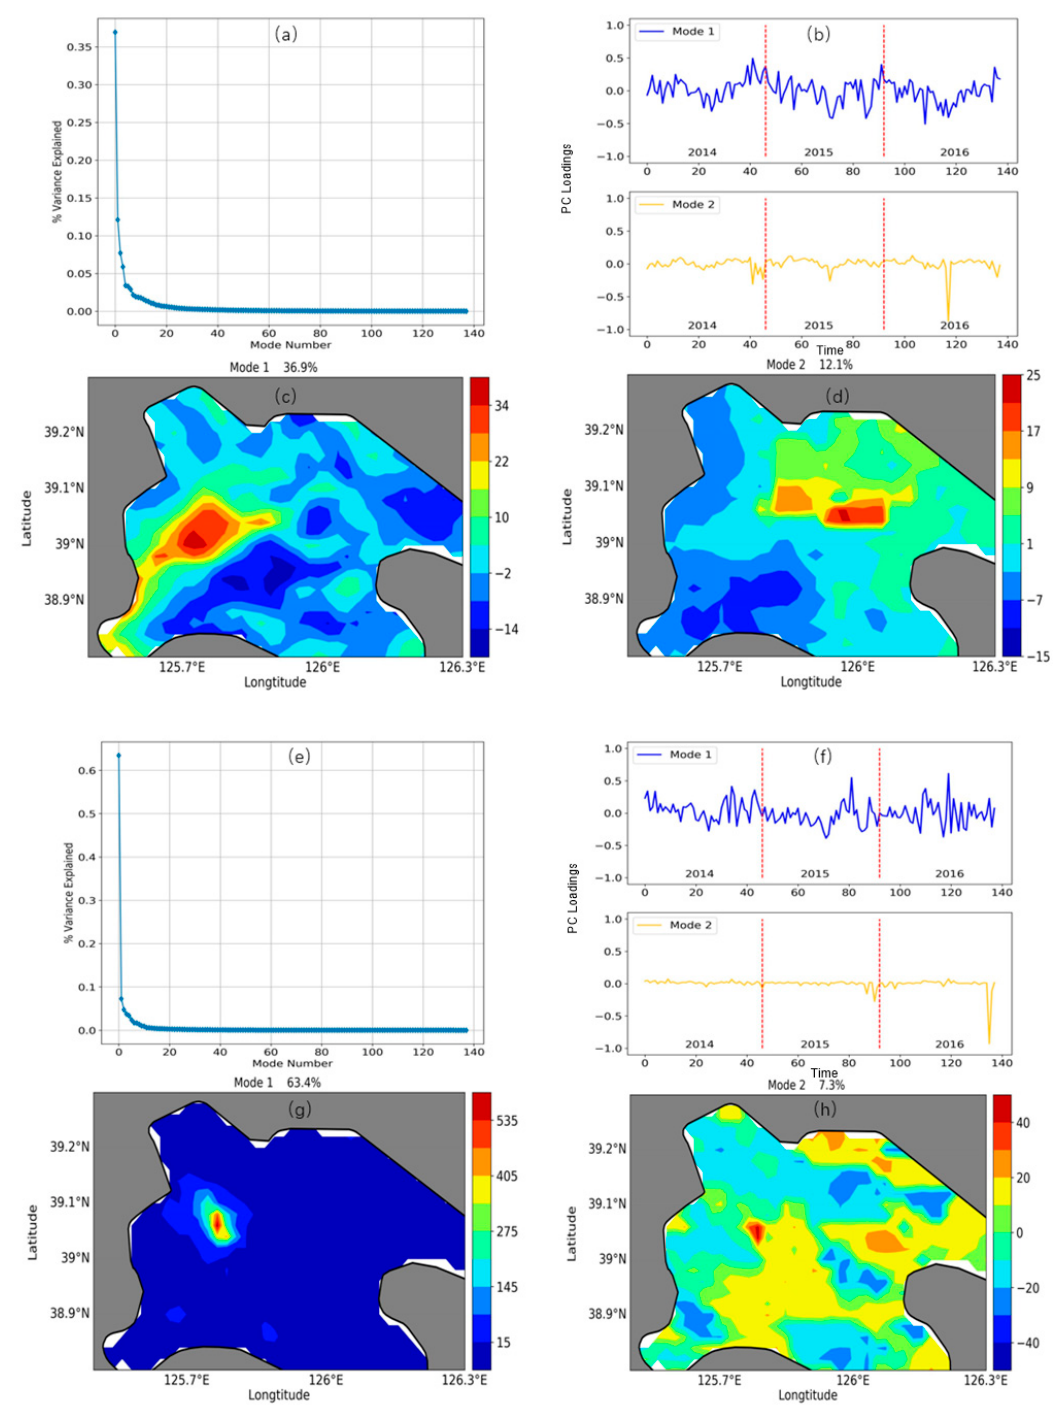
Figure 10. The T-mode PCA results for Pyongyang LST (the first four panels) and DNB (the last four panels) data during 2014–2016. ( a ) the variance explained by the principal covariance analysis (PCA) modes for LST, ( b ) the PC time series for the first two modes of LST (the red vertical lines are used to divide data into different years, ( c , d ) the spatial patterns of the first two modes for LST PCA results, ( e ) the variance explained by the principal covariance analysis (PCA) modes for DNB, ( f ) the PC time series for the first two modes of DNB, ( g , h ) the spatial patterns of the first two modes for the DNB PCA results.